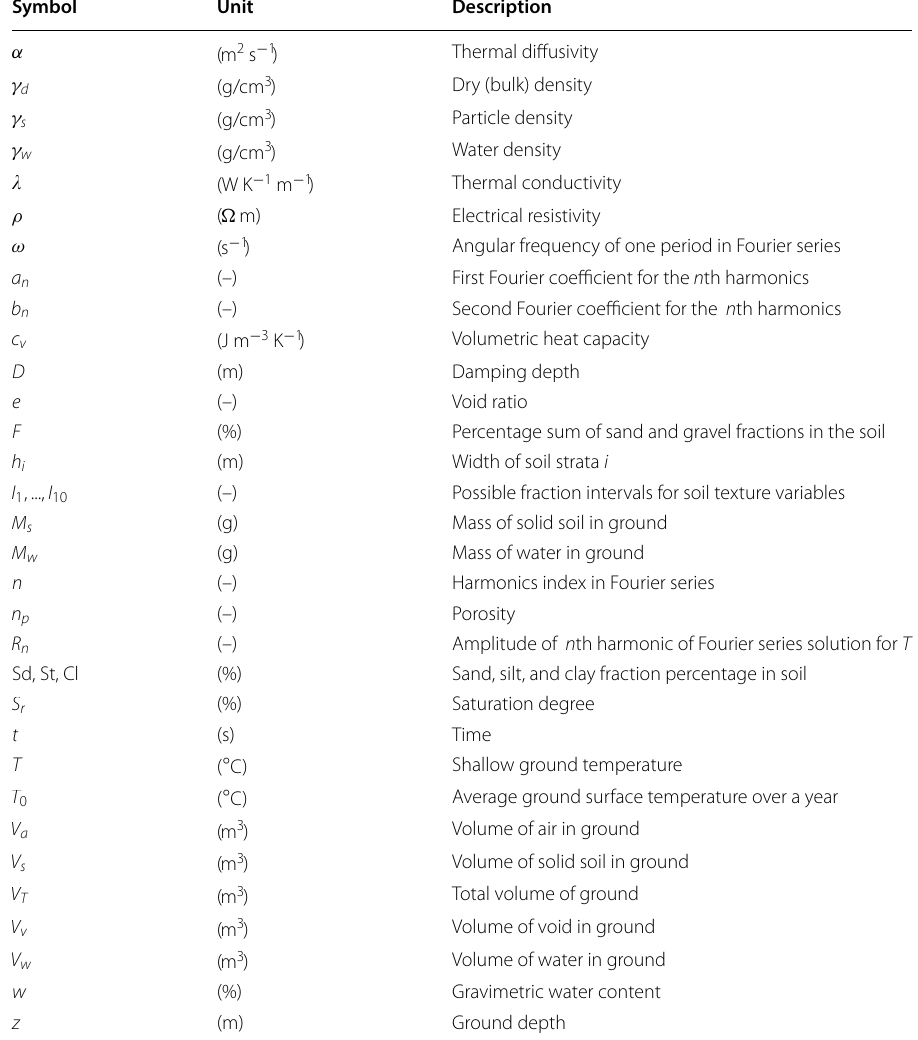
Table 11 Detailed nomenclature for geothermal and soil-related